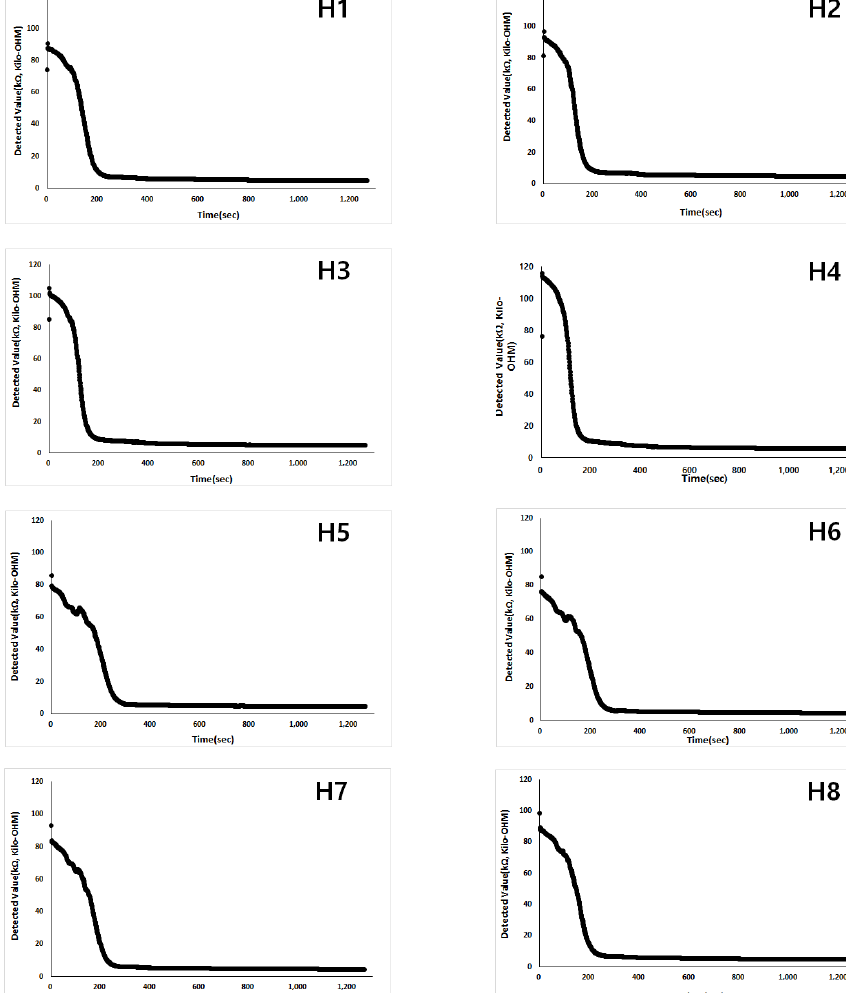
Figure 7. Variation of H1 – H8 CdS photoresistors in sludge sedimentation detecting.